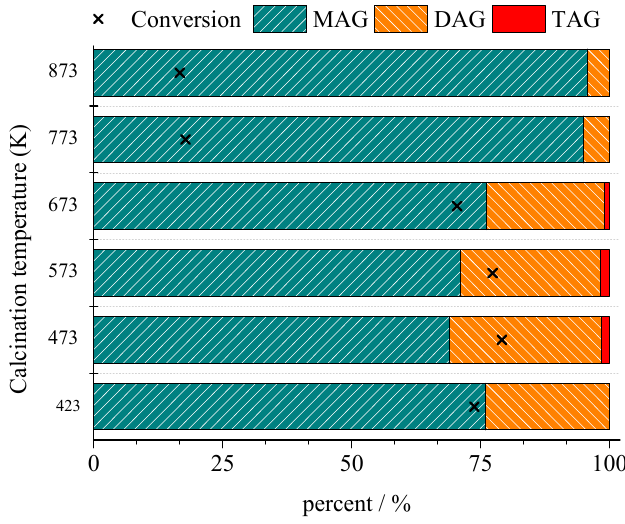
Figure 18. Impact of thermal treatment on the activity of Sn 3/2 PW 12 O 40 catalyst in esterification reactions of glycerol with HOAc (adapted from ref. [57]). Reaction conditions: glycerol (24.0 mmol); HOAc (72.0 mmol); temperature (333 K); catalyst (0.10 mol % Sn 2+ ); volume (10 mL). The thermal treatment at 573 K of the Sn 3/2 PW 12 O 40 catalyst improved its catalytic performance. However, temperatures greater than 673 K led to a strong decrease in the